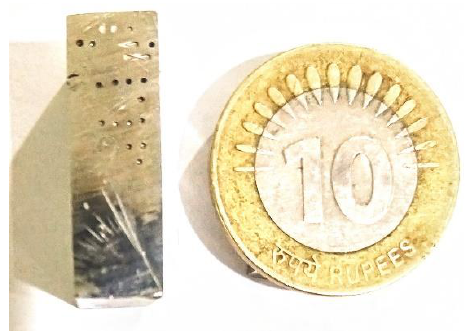
Figure 3. Fabricated microholes on the AISI 216 SS workpiece. Table 1. Parameters and their levels.